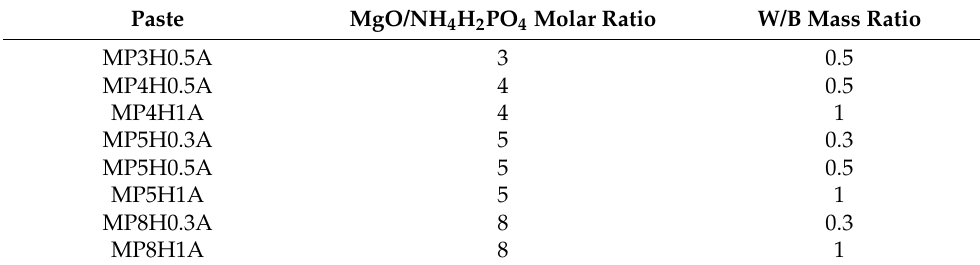
Table 6. Mix proportion of MAPC pastes.